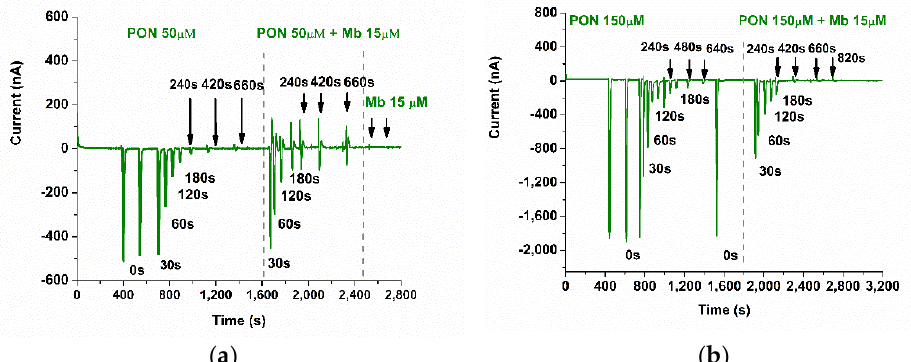
Figure 13. Chronoamperogram using the FIA-EC system for ( a ) 50 µM and ( b ) 150 µM PON, in the presence and in the absence of 15 µM metMb, at different incubation periods (0, 30, 60, 120, 240, 420, 660, 820 s). The decomposition of PON alone was studied at the same incubation periods to prove that the recovery of the current is due to the presence of PON in the metMb solution and not to the metMb itself (PBS pH 9, 0.1M, E = 0.1 V and flow rate 0.4 mL/min). The values obtained in these studies were further used for kinetic calculations.